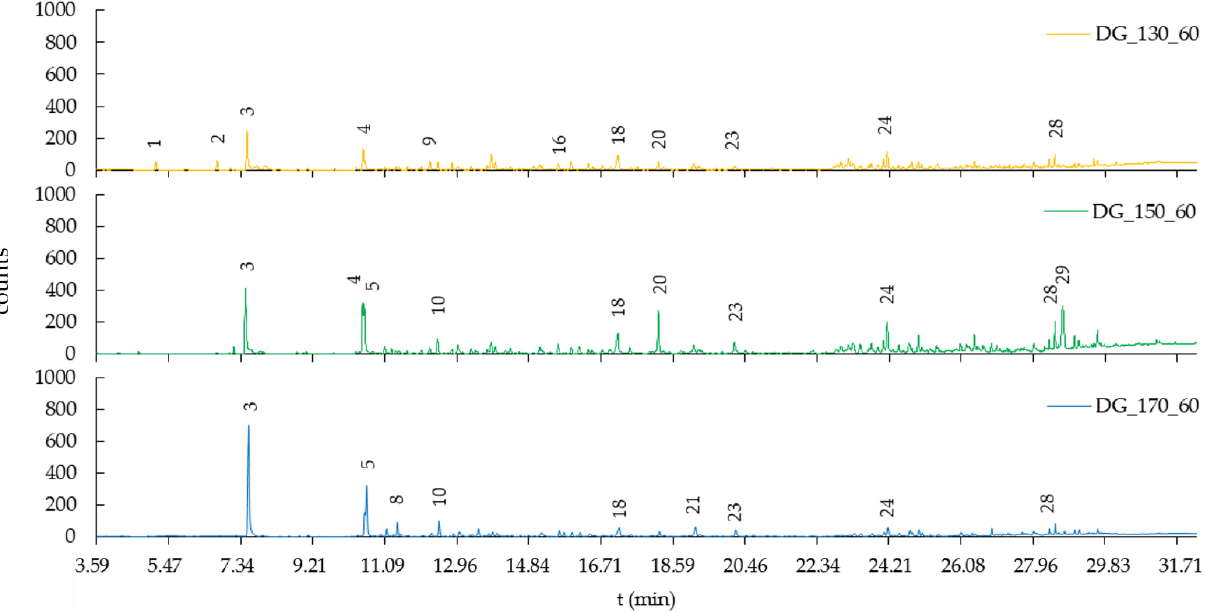
Figure 3. GC-MS diagram of the digestate (DG) hydrothermally treated at 130, 150 and 170 °C with a 60 min holding time, see peak numbers in Table 6.